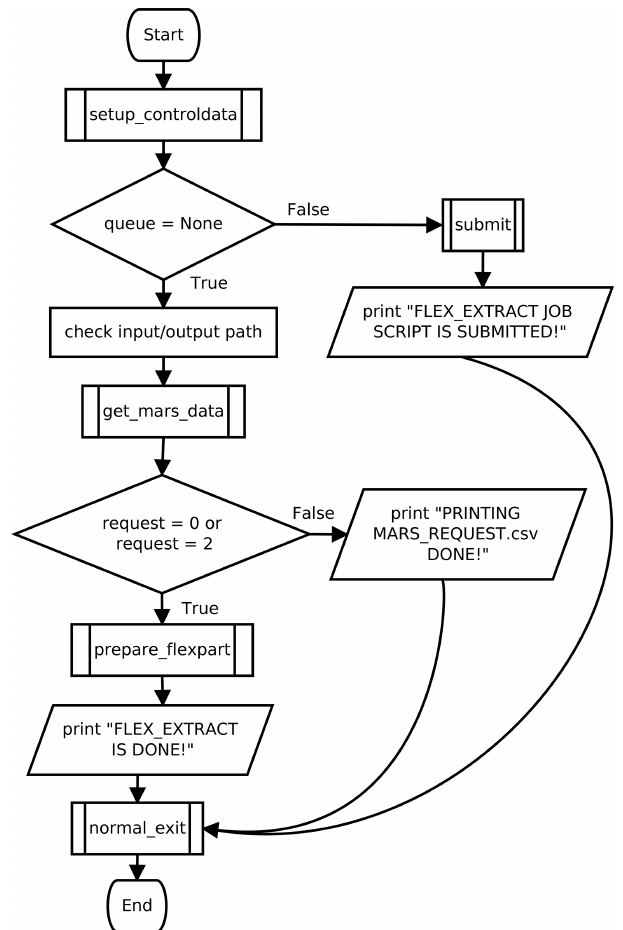
Figure 3. Flow diagram for the local application mode. If queue (cid:54)= None , flex_extract was started in remote or gateway mode and Fig. 2 applies. This is marked by the submit block. In